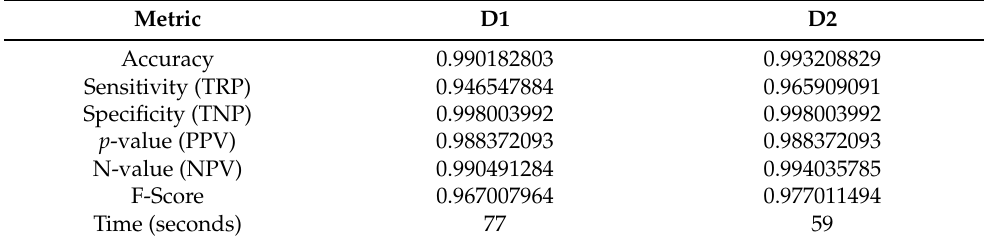
Table 14. The performance of the BRNN after optimization using the proposed DWDTO applied to the two datasets, D1 and